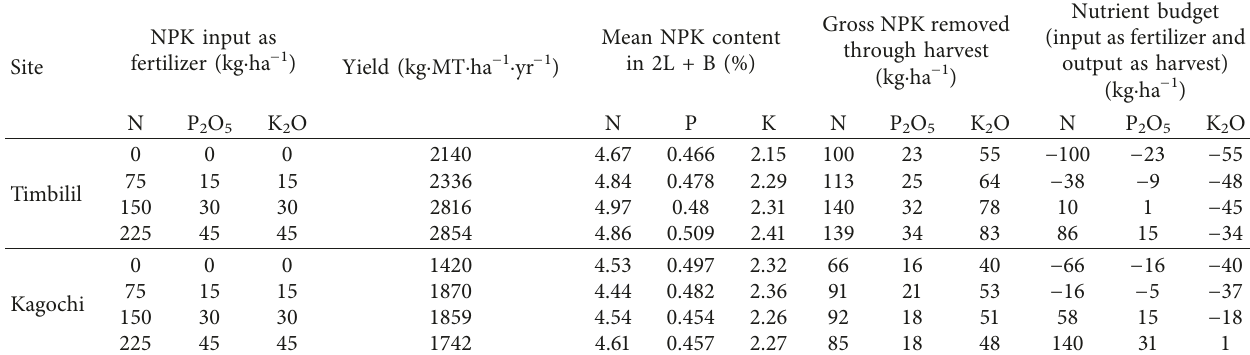
“ − ” denotes a negative value. Table 2: Apparent nutrient budget of Blend B (NPKS 23: 5:5 :4 + 10Ca + 3Mg + trace elements) in Timbilil and Kagochi. NPK input as Site